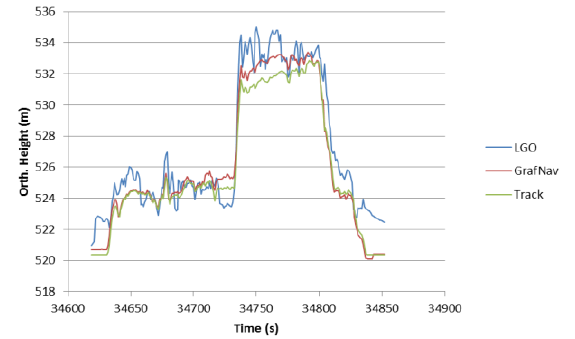
Figure 6. Height profiles of the trajectories corresponding to Figure 5.